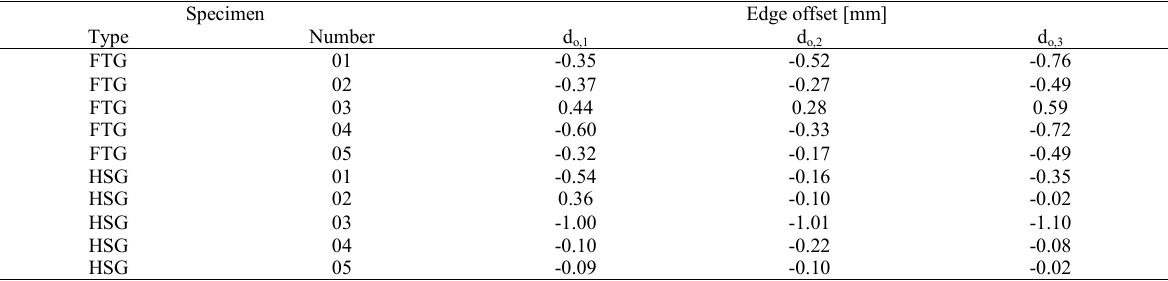
Table 3: Edge offset at three